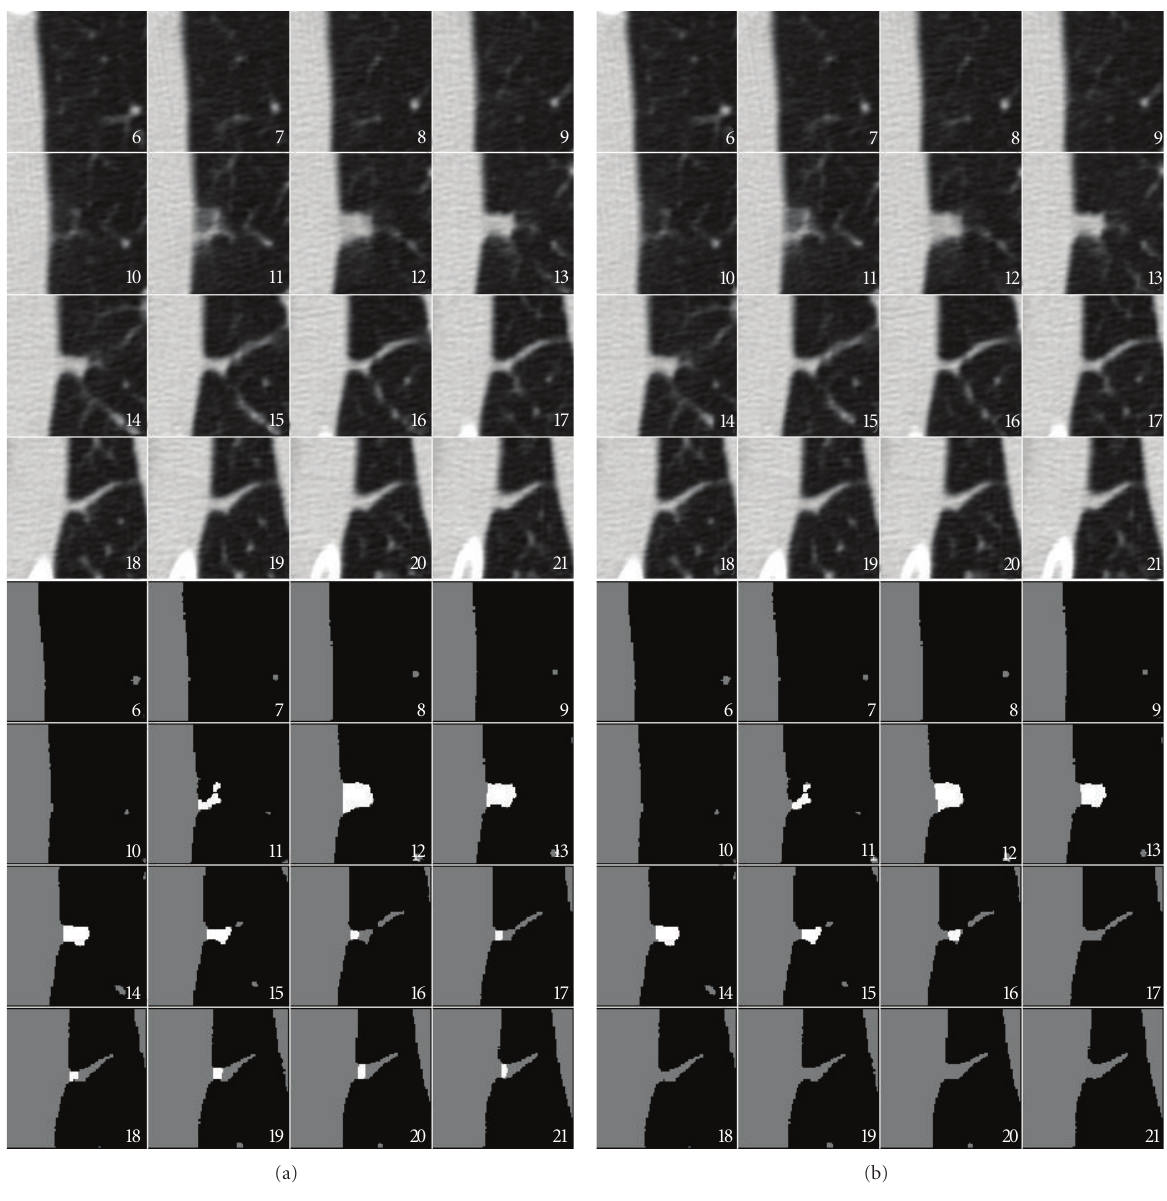
Figure 18: Example of oversegmentation by both algorithms. (a) An attached structure is included in the segmentation by the surface-fitting method as well as the (b) plane-cutting method, though not to as great an